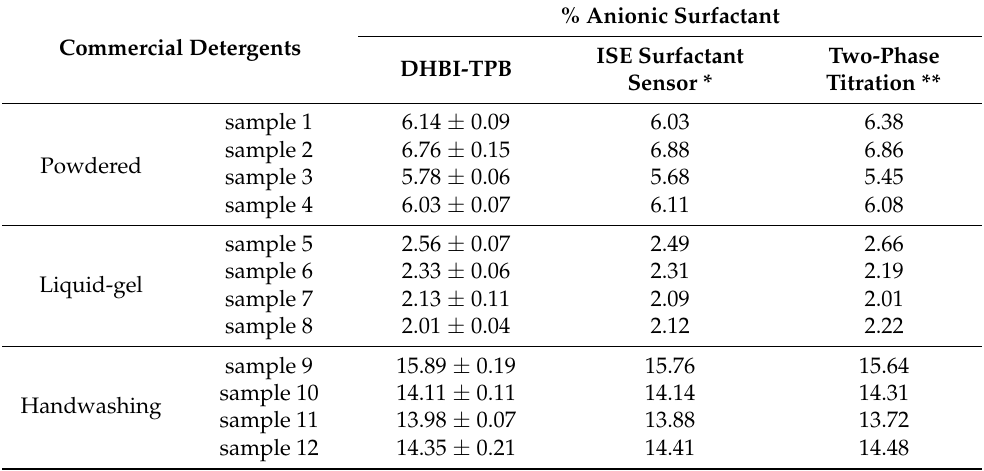
Table 4. Results for potentiometric titration of commercial products containing anionic surfac- tants by the DHBI-TPB surfactant sensor compared with ISE surfactant sensor and a two-phase titration